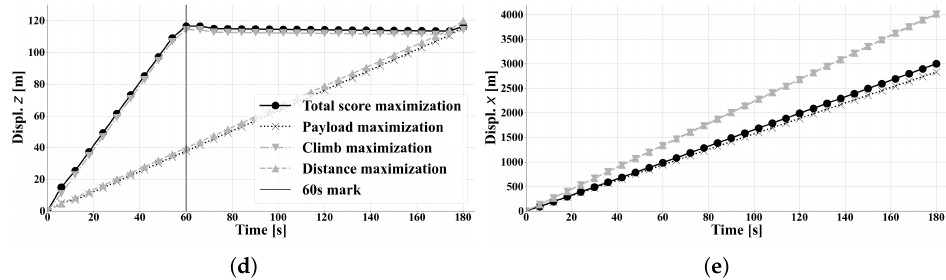
Figure 21. Optimal trajectory: ( a ) Vertical displacement; ( b ) Horizontal